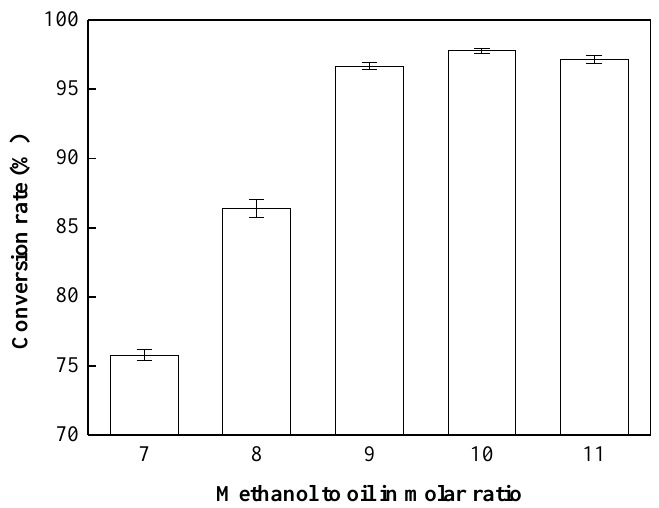
Figure 3. Effects of methanol-to-oil molar ratio on the transesterification reaction. Reaction conditions: methanol-to-oil molar ratio, 7:1–11:1; amount of catalyst used, 0.75 wt %; rotation speed, 7000 rpm; reaction temperature, 65 °C; and reaction time, 8 min.